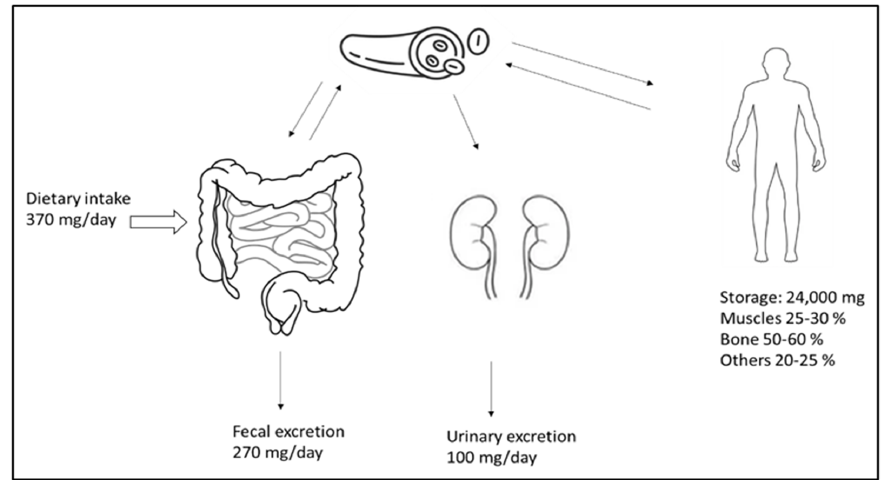
Figure 1. Magnesium homeostasis. The magnesium intake, excretion, and distribution in the body. Adequate intake covers the daily loss of magnesium.